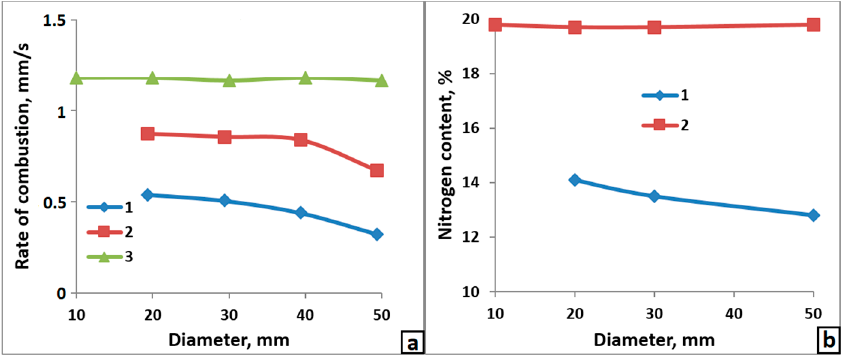
Figure 6. ( a ) Impact of sample diameter on chromium combustion rate. 1—0.4 MPa, 2—1.0 MPa, 3—5 MPa. ( b ) Impact of sample diameter on nitrogen content in chromium. 1—0.4 MPa, 2—5 MPa.